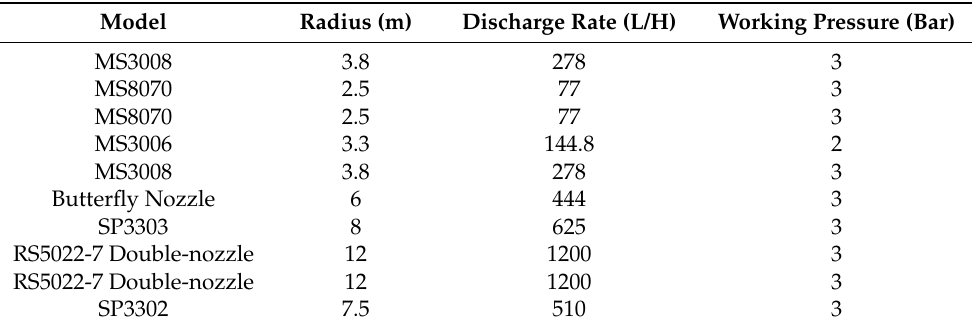
Table A1. Sprinkler/Sprayer technical